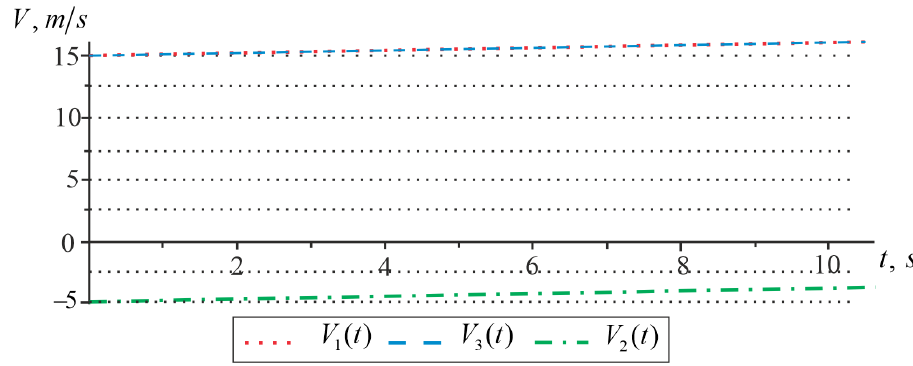
Figure 5. Measured absolute velocities along each of the beams (first simulation).